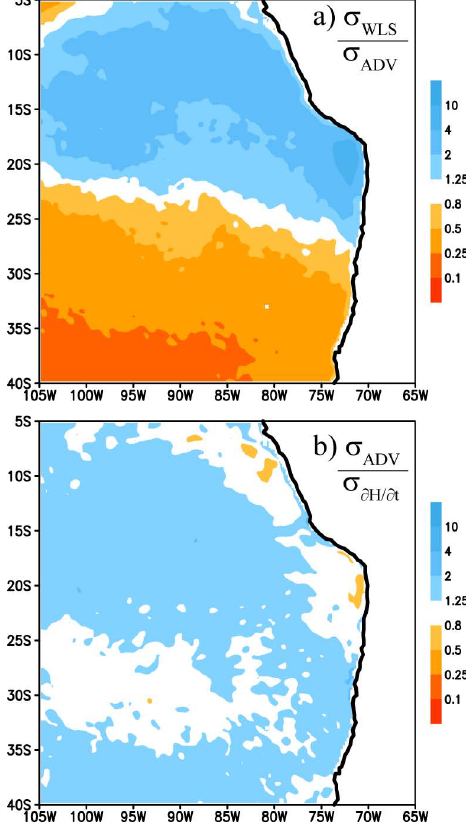
Fig. 7. Ratios of standard deviations of (a) large scale subsidence to advection and (b) advection to ∂H/∂t . All fields from the WRF